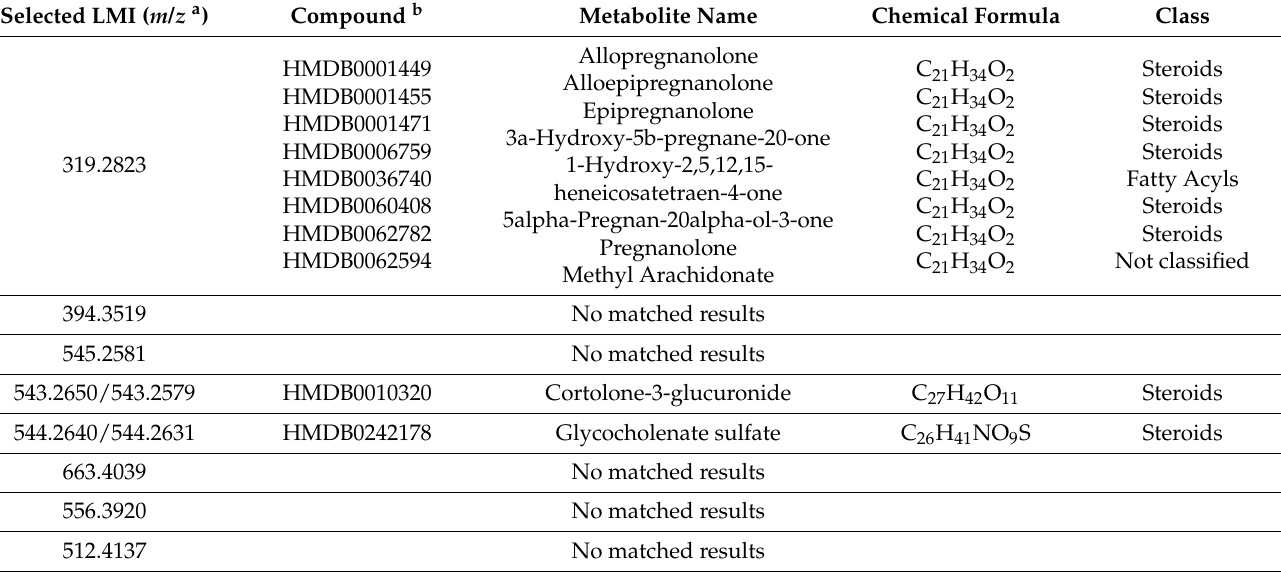
Table 4. Top 10 low mass ions increased in the ventricular CSF compared with the paired lumbar CSF. Selected LMI ( m / z a )